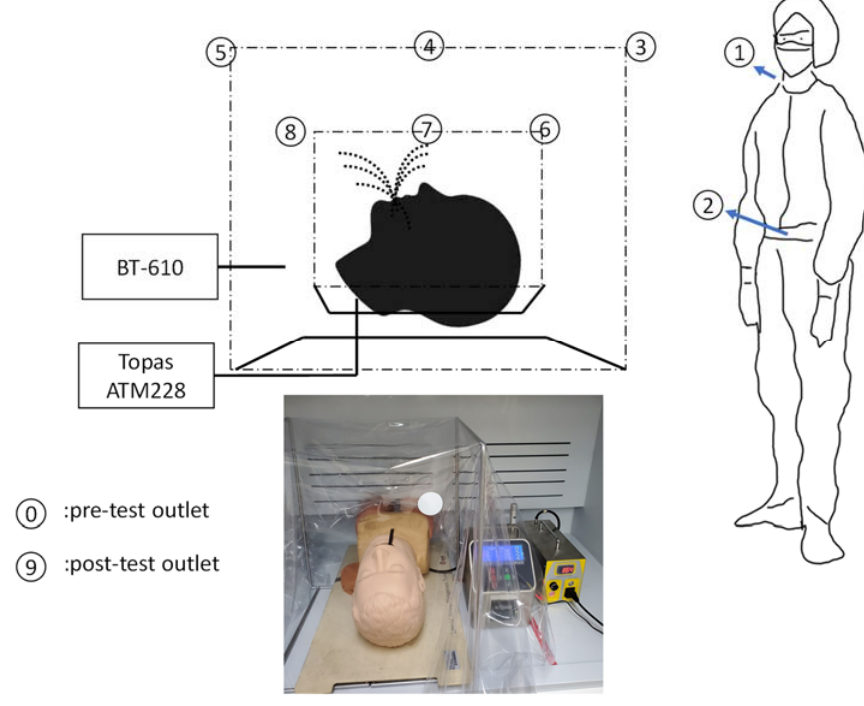
Figure 2. The experimental set up. Numbers 0~10 are the collection locations.